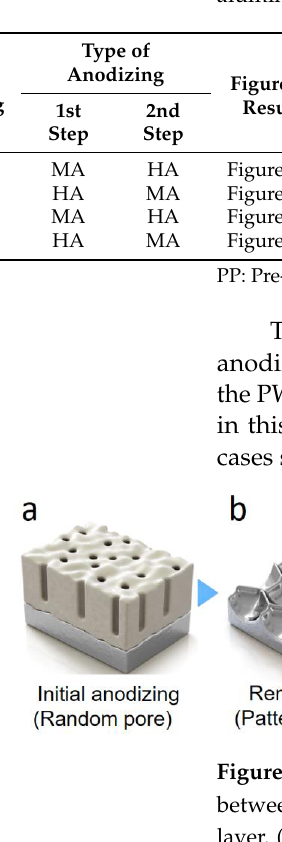
Table 1. Stepwise anodizing conditions and the structural dimensions of the anodized nanoporous alumina with no intermediate pore-widening step.